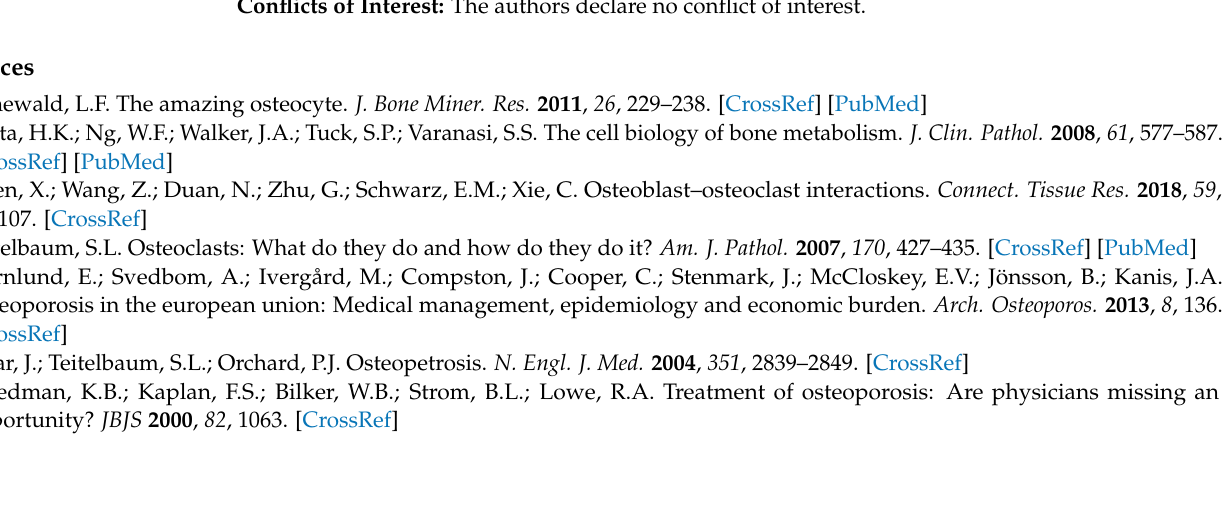
Figure S2: Original blots of Western blot. Original blots of Figure 4; Table S1: The content of 2-furoic acid in